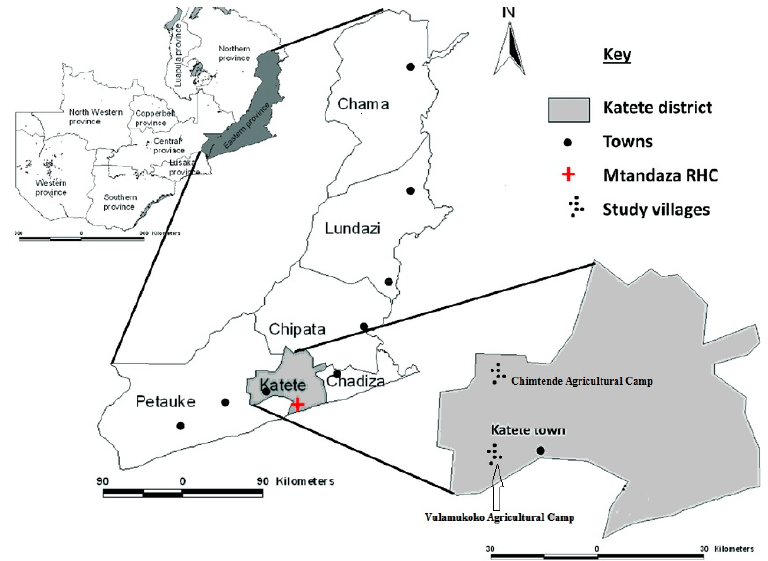
Figure 1. Location of Katete district in Zambia . Source: Authors’ compilation .